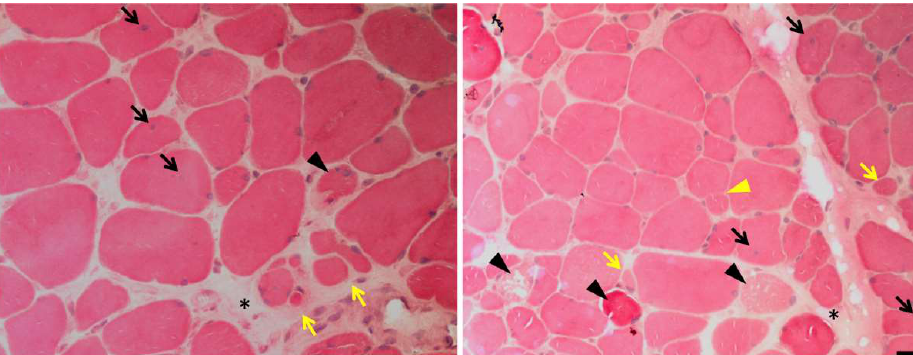
Figure 2. Illustration of the pathological features of CAPN3 deficiency in the skeletal muscle.